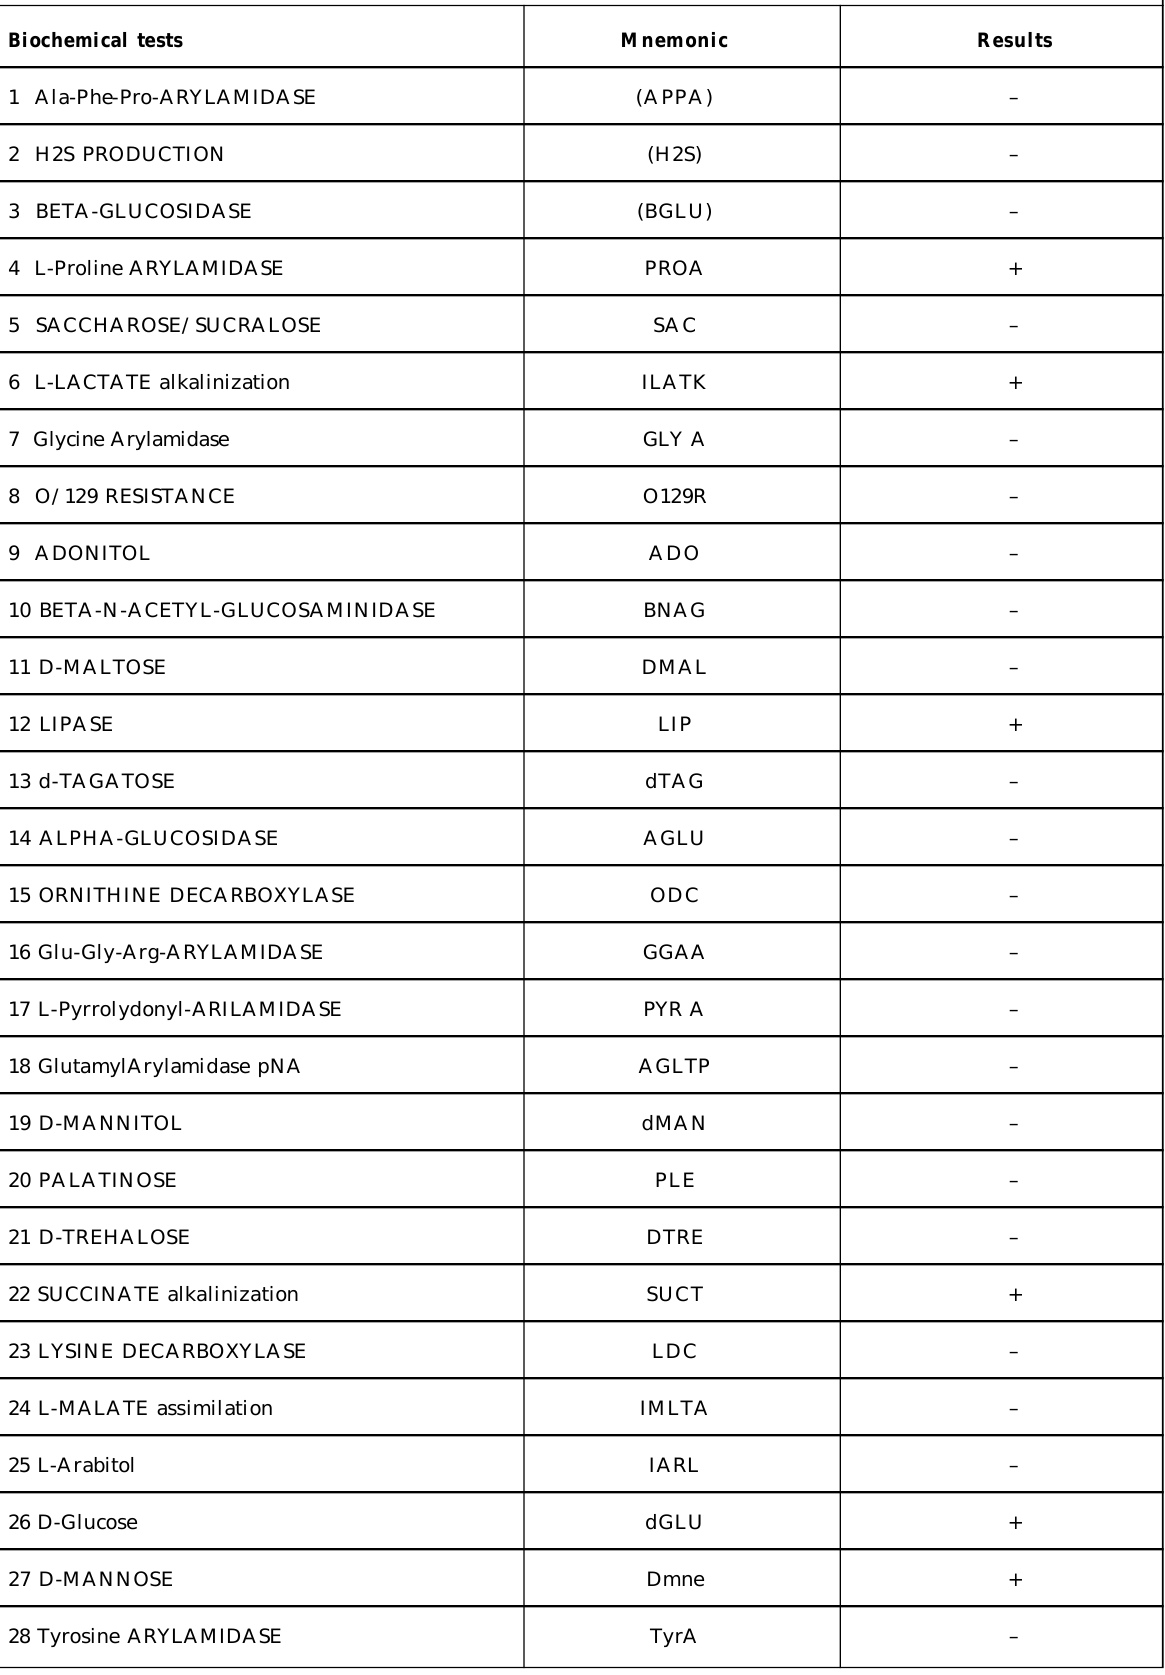
Table 1: Biochemical test results for bacteria isolated from patient from